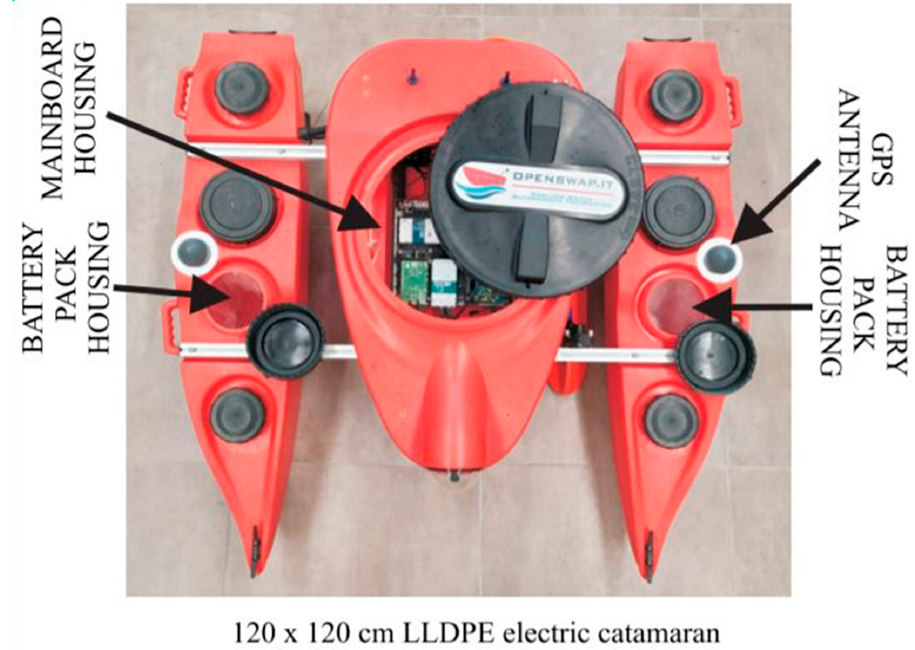
Figure 3. Photo and technical details of the latest OpenSWAP vehicle.